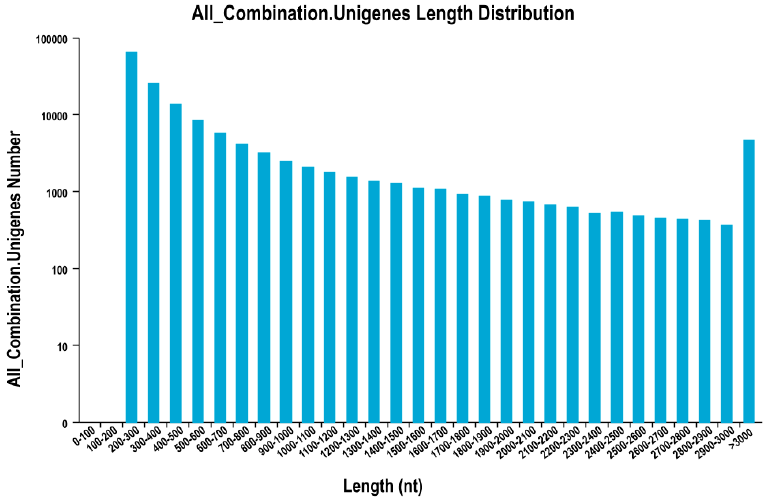
Figure 2. Length distribution map of unigene. The x -axis represents the different length intervals of unigene; The y -axis represents the number of unigene in a certain length interval.